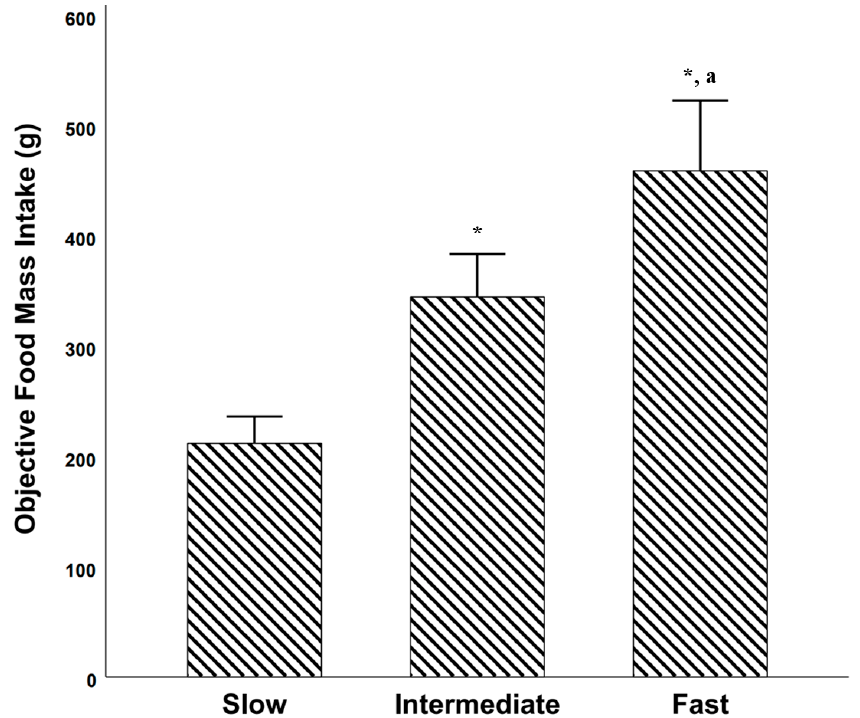
Figure 4. Food mass intake (g) among students who were considered as slow eaters (objective eating rate below 33 percentile), intermediate eaters (objective eating rate between percentiles 33 and 66) and fast eaters (objective eating rate above 66 percentile). * = significantly different vs. slow eaters. a = significantly different vs. intermediate eaters. Error bars represents 95% confidence